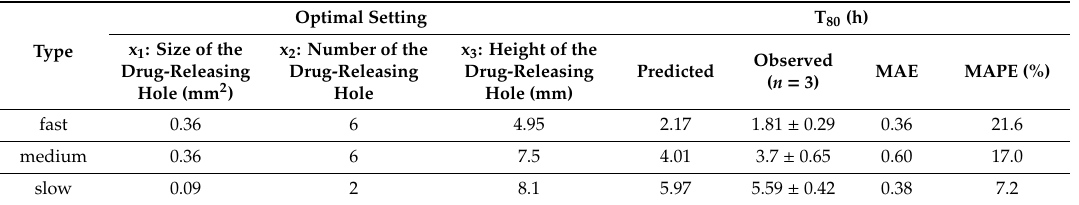
Table 3. The optimal settings of control factors and the responses (T 80 ) for drug delivery systems to